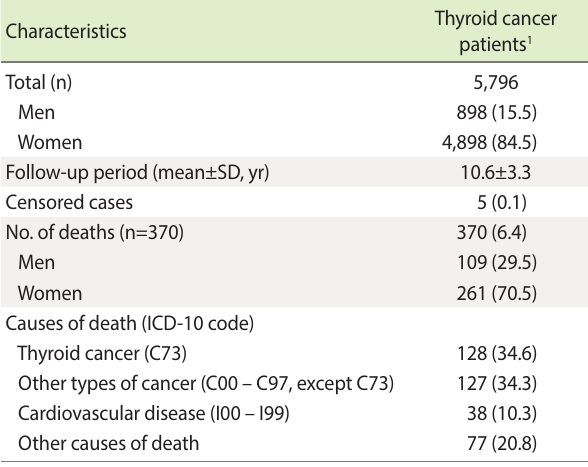
Table 2. Number and causes of death among thyroid cancer pa-